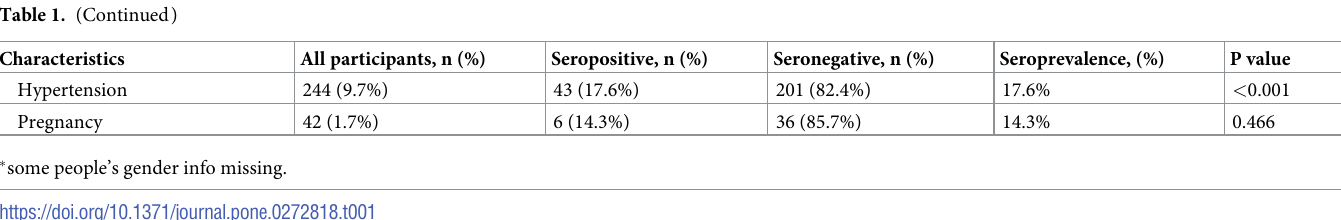
Table 2. Being a non-smoker, non-Saudi, previously diagnosed with COVID-19 infection by PCR, and having diabetes and hypertension were statistically significantly different by sero- prevalence status Table 1.